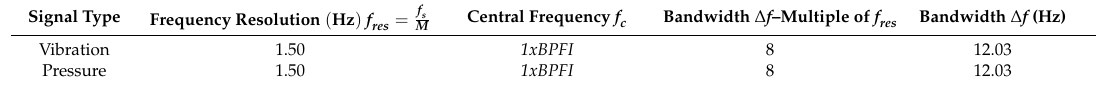
Table 4. Health indicator (HI)